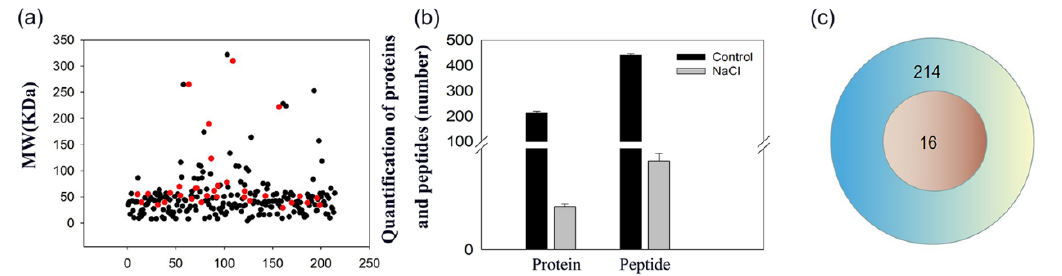
Figure 2. Molecular mass distribution and number of proteins in salt gland secretion sap of L. bicolor. ( a ) Black points are the control group, red points are the salt treatment group; ordinate is the molecular mass of the protein, and abscissa is the protein number; ( b ) Black column represents the control group, and the gray represents 200 mM NaCl treatment; ( c ) Venn pattern of proteins in salt gland secretion sap of L. bicolor. The blue circle shows the protein number of control, and the red circle shows the number of proteins under 200 mM NaCl treatment.